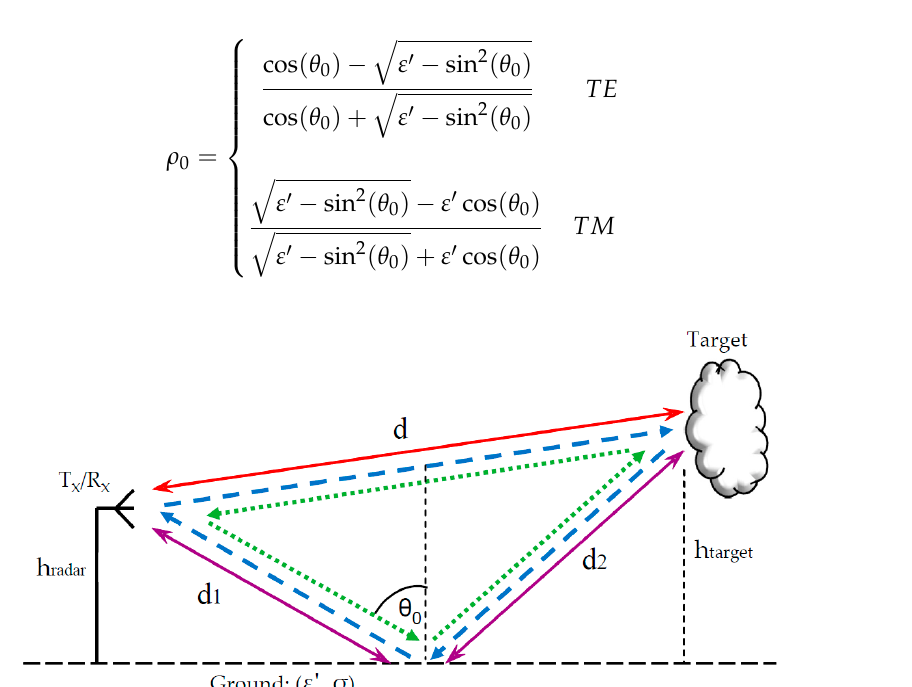
Figure 1. Four main propagation paths in a radar scenario.